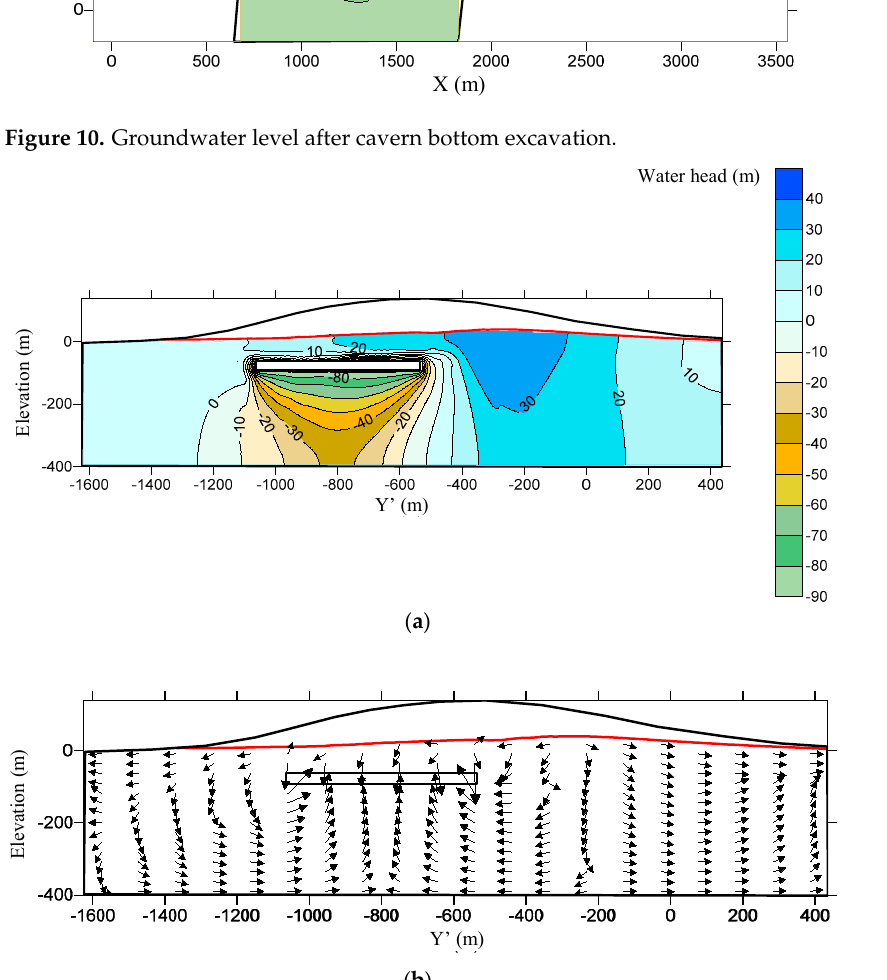
Figure 11. Water head condition after cavern bottom excavation: ( a ) water head contour; ( b ) water head gradient vector